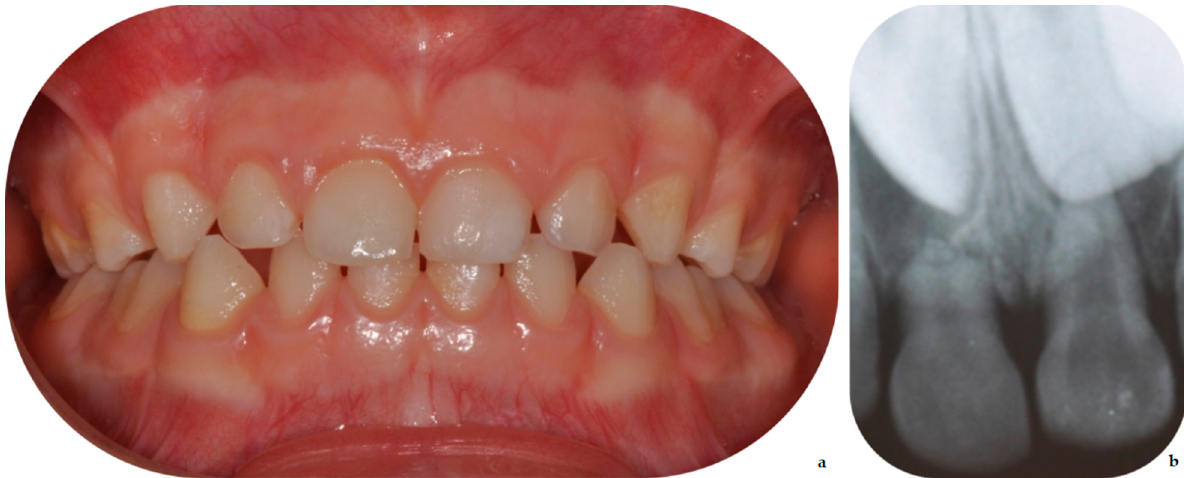
Figure 3. Good healing of the traumatized tooth and supporting tissues ( a ); in the radiograph ( b ) early signs leading to PCO and resorption of the radicular fragment.